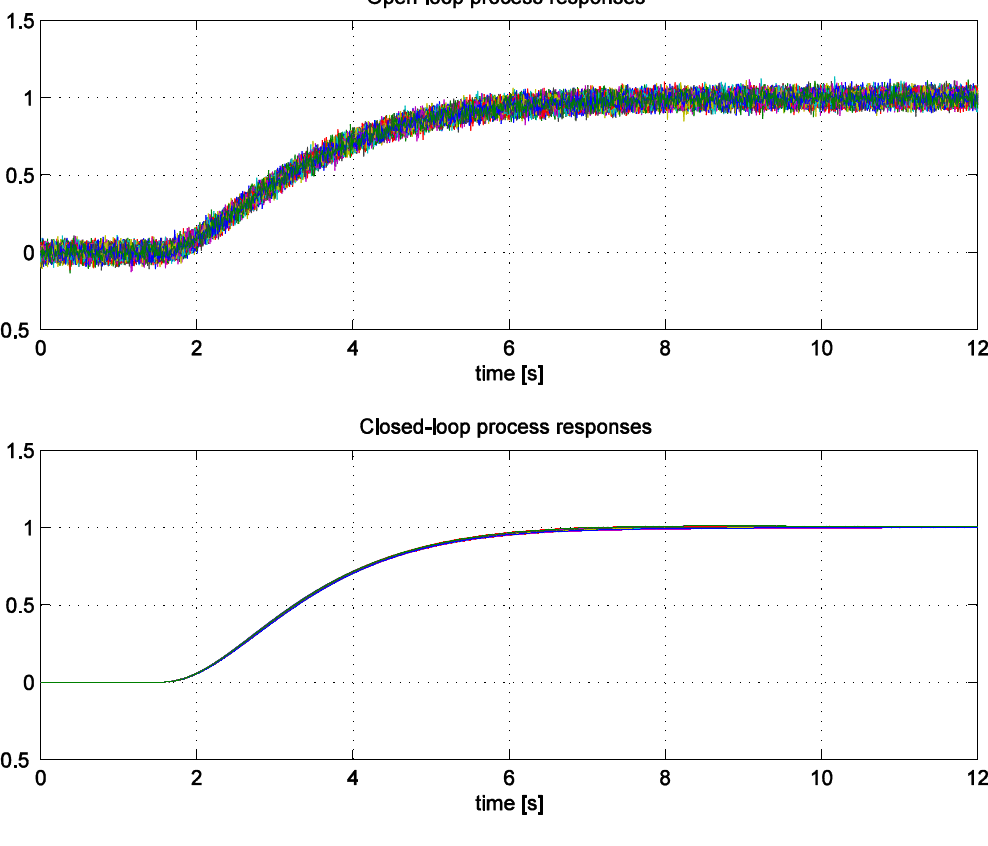
Figure 12. One hundred process open-loop responses with measurement noise ( top figure ) and closed-loop responses ( bottom figure ) using FWLS tuning method without additional noise (for clarity).